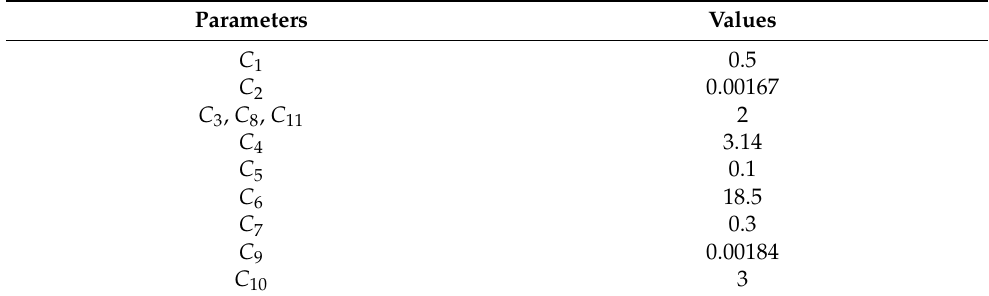
Table 3. Power coefficient parameters of the turbine.